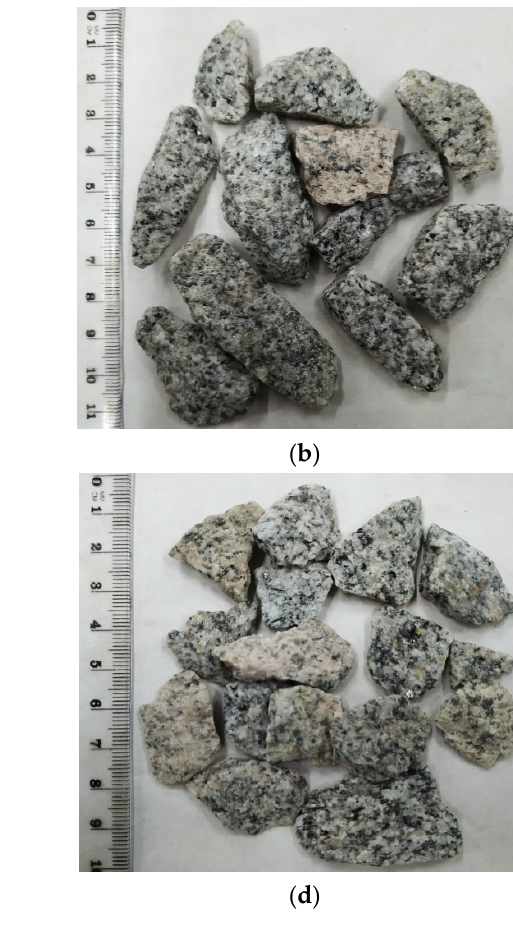
Figure 4. Geometric characteristics of aggregate particles for granite (size fraction 14–16 mm): ( a )—non-flaky cubical particles; ( b )—non-flaky non-cubical particles; ( c )—flaky cubical particles; ( d )—flaky non-cubical particles.